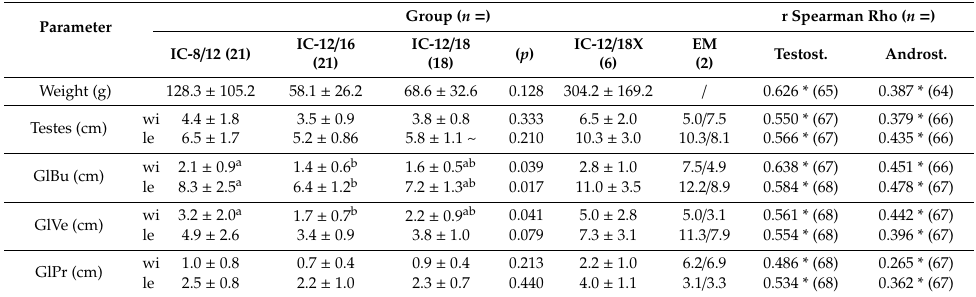
Table 6. Size (cm) of accessory glands and testes and weight (g) of testes (mean ± SD) of group EM, IC-8 / 12, IC-12 / 16, IC-12 / 18, IC-12 / 18X, and correlation between sizes and testosterone concentration in serum and androstenone concentration in fat tissue at slaughter of IC groups.